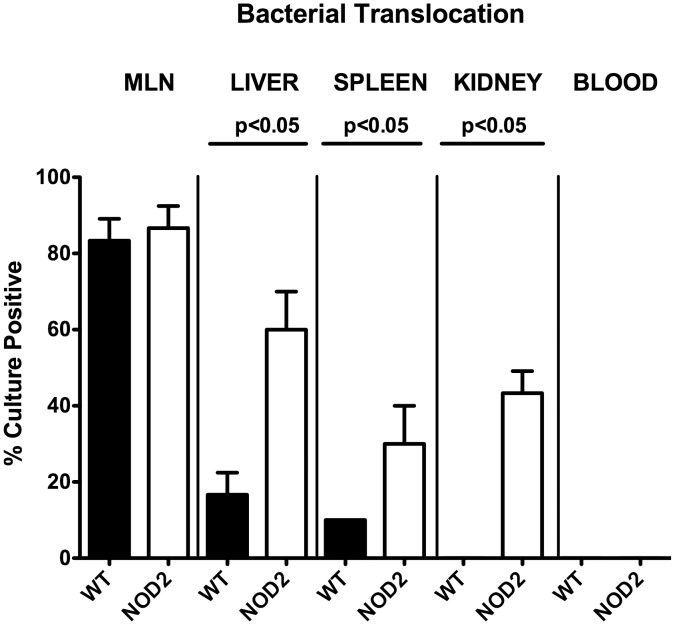
Bacterial translocation in NOD2 deficient following ileitis induction.Relative translocation frequencies (%) of live bacteria were determined in ex vivo biopsies of mesenteric lymphnodes (MLN), liver, spleen, kidneys, and blood derived from C57BL/6 wildtype (WT; black bars; n = 10) and NOD2-/- (NOD2; white bars; n = 10) mice by culture in enrichment broths seven days after ileitis induction. Medians, standard deviations and significance levels (p-values) determined by Mann-Whitney-U test are indicated. Data shown are pooled from three independent experiments.